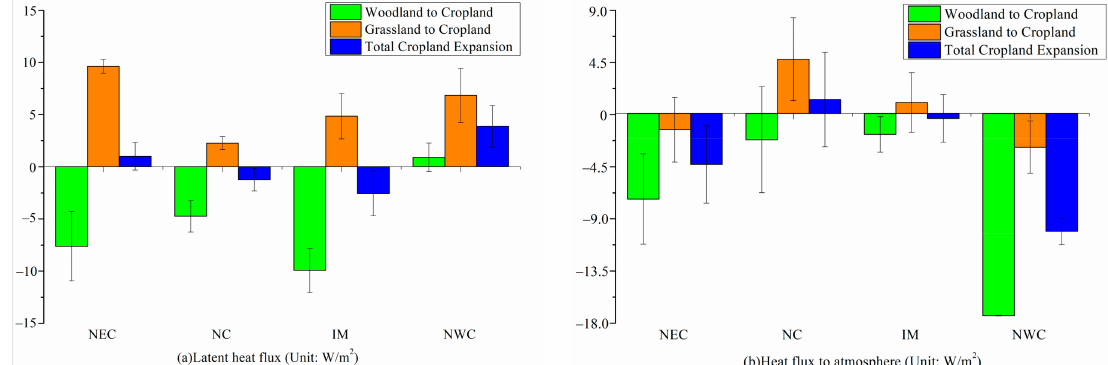
Figure 10. Changes of latent heat flux ( a ) and heat flux to the atmosphere ( b ) due to cropland expansion in different